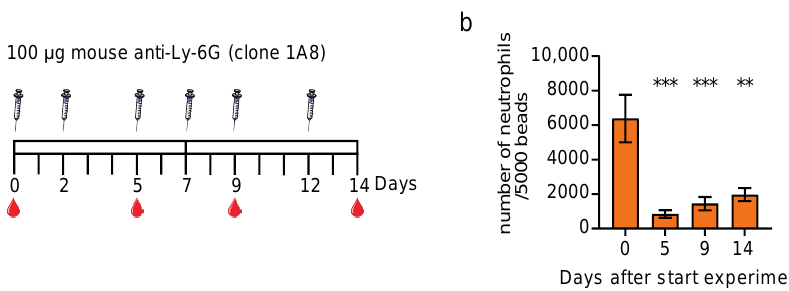
Figure 4. Mouse-Ly-6G efficiently depletes neutrophils in FcR γ -deficient mice. ( a ) Experimental set-up; FcR γ − / − mice ( n = 5) were i.p. injected three times a week with 100 µ g mouse-Ly-6G antibody, and blood was drawn via cheek puncture before the start of the experiment, and at days 5, 9, and 14; ( b ): FcR γ − / − mice show depletion of the number of CD45 + Siglec-F − CD115 − SSC high Gr-1 + CD11b + neutrophils in the peripheral blood (shown per 5000 latex beads) at all time points. Data is presented as mean with SEM. Statistics: one-way ANOVA with Bonferroni correction, ** = p <0.01, *** = p <0.001.